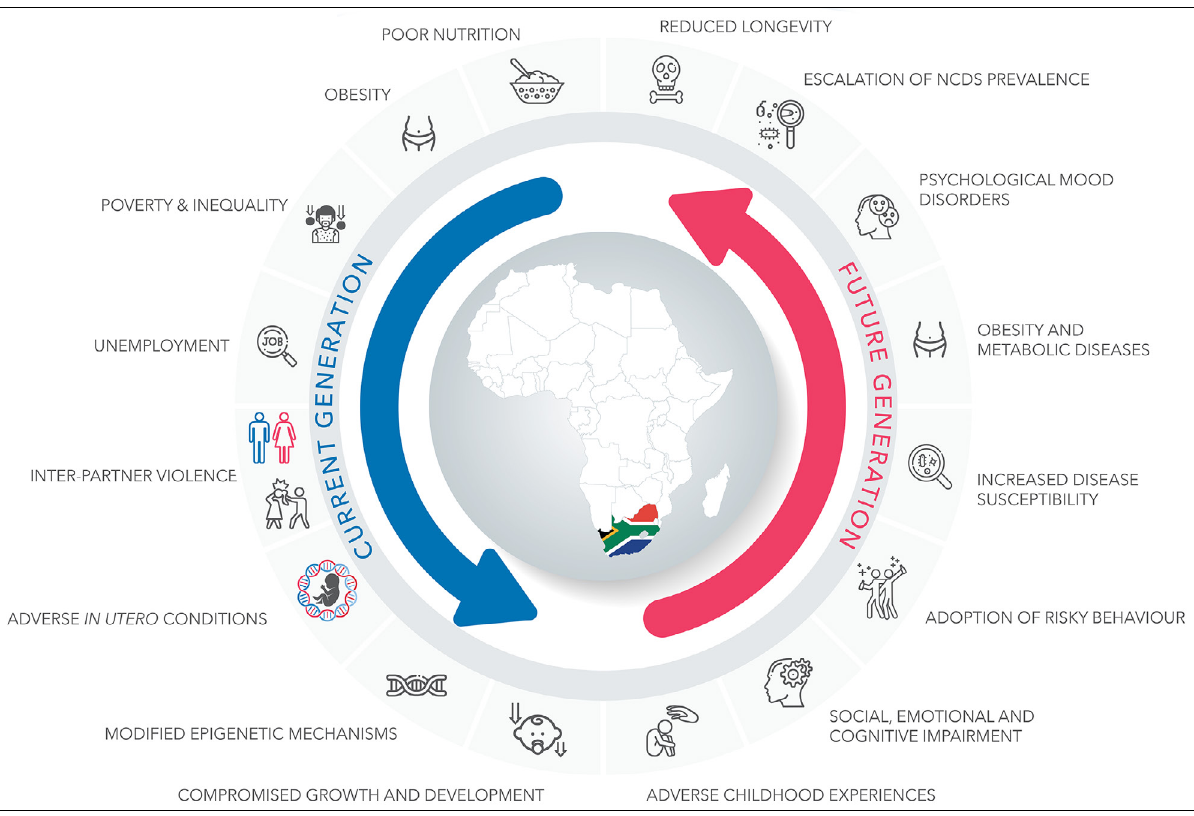
Figure 1: A cycle of non-communicable diseases in South Africa, in which adverse socio-environmental factors affecting a large number of children exponentially increase their susceptibility to diseases and promote the development of chronic illnesses in adulthood – the effects of which can potentially be perpetuated across